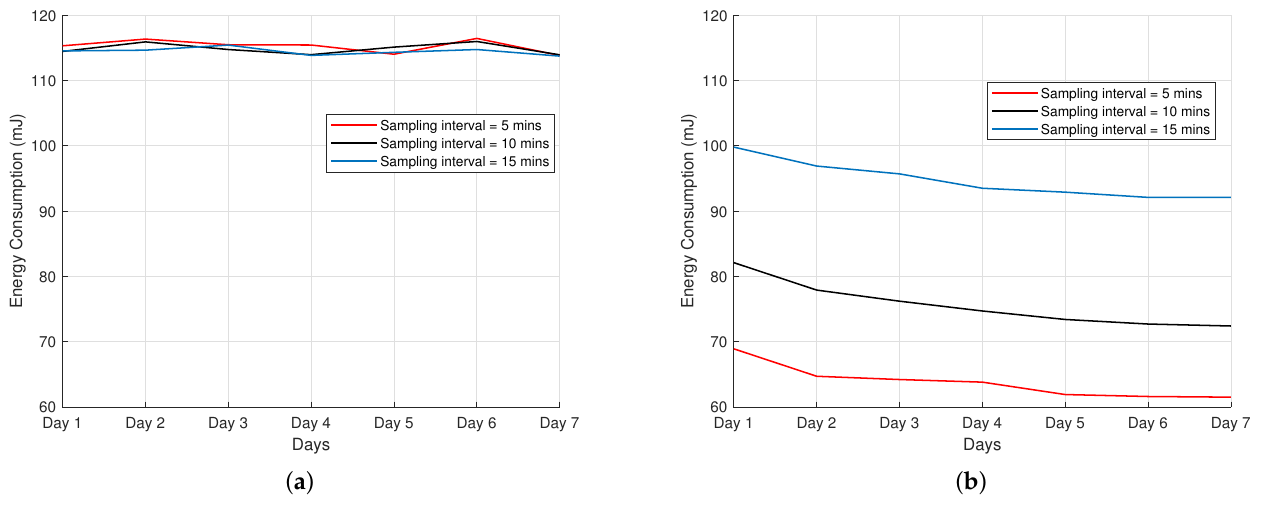
Figure 10. Energy consumption: ( a ) ADR disabled; ( b ) ADR